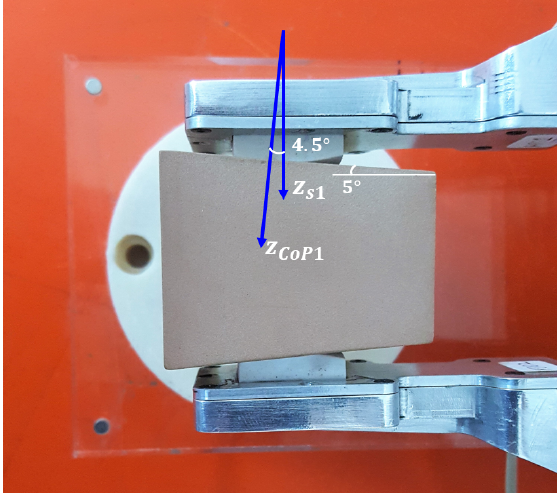
Figure 20. Fourth experiment: Grasp to validate the contact geometry estimation